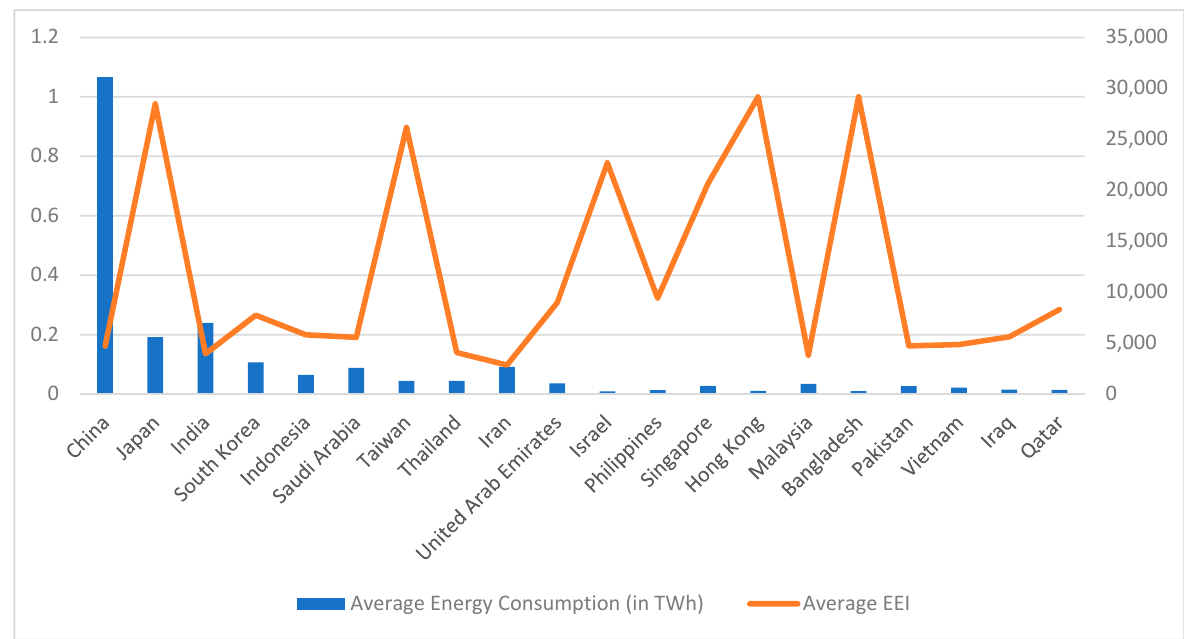
Figure 3. Comparison between the average environmental efficiency indicator (EEI) and the average energy consumption. Source: authors’ estimation.